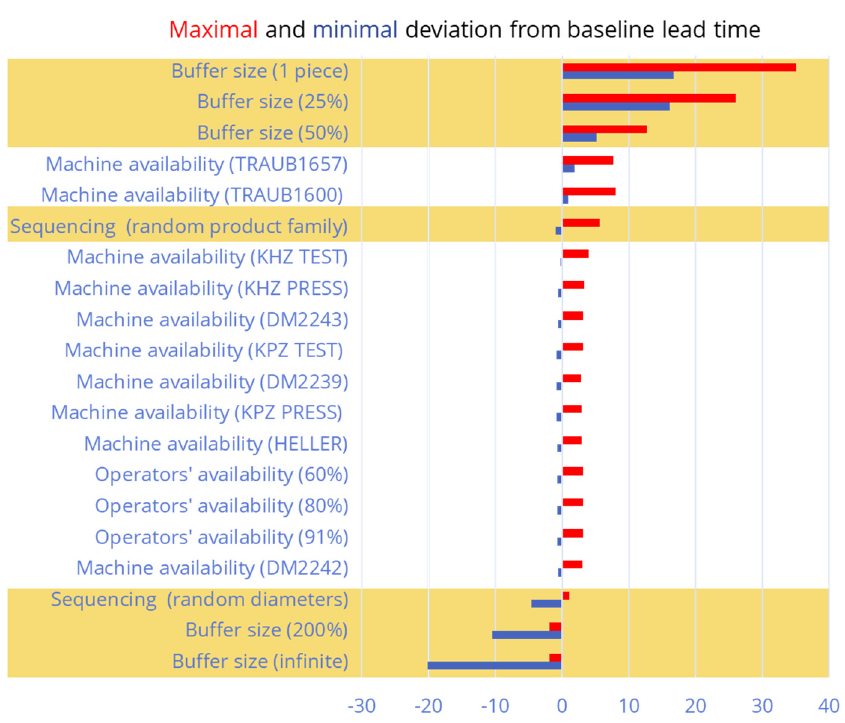
Figure 9. Result of the rough-cut sensitivity analysis: the tornado diagram.